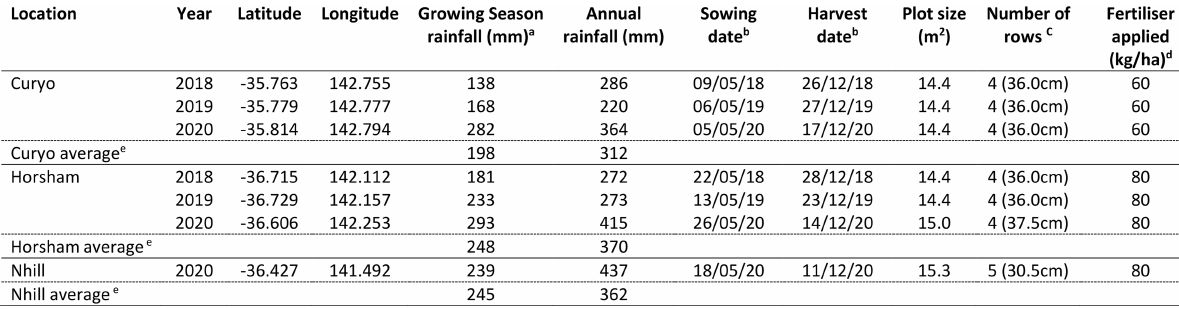
TABLE 1 Summary of experimental location and environmental data.